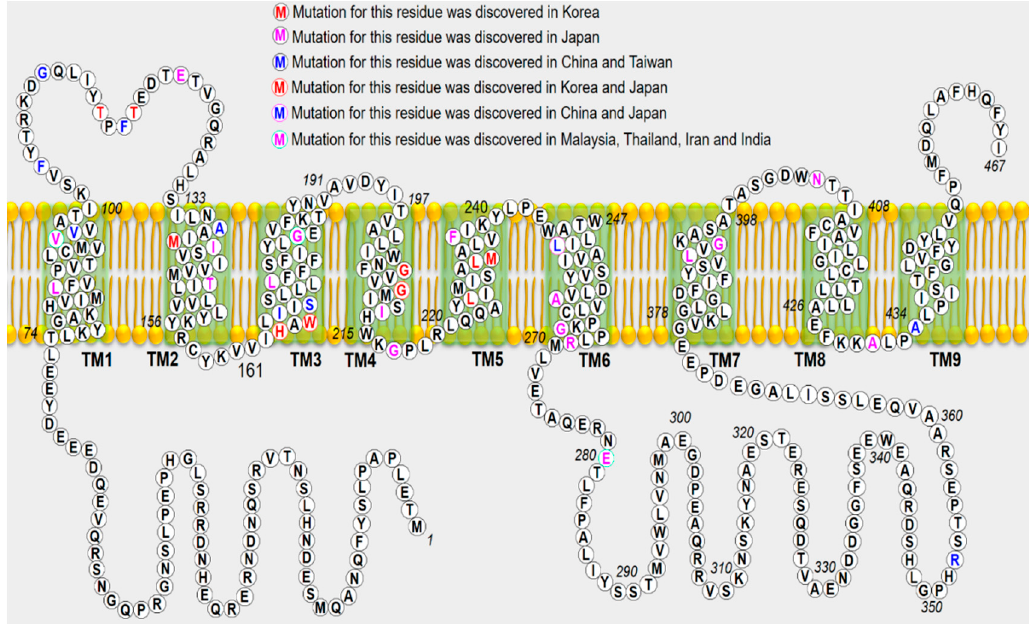
Figure 3. Mutated PSEN1 residues identified in the Asian countries are shown in different colors. The predicted membrane topology of PSEN1 with the nine transmembrane domains (green shaded boxes) and boundaries between coding exons is shown. TM, transmembrane domain.